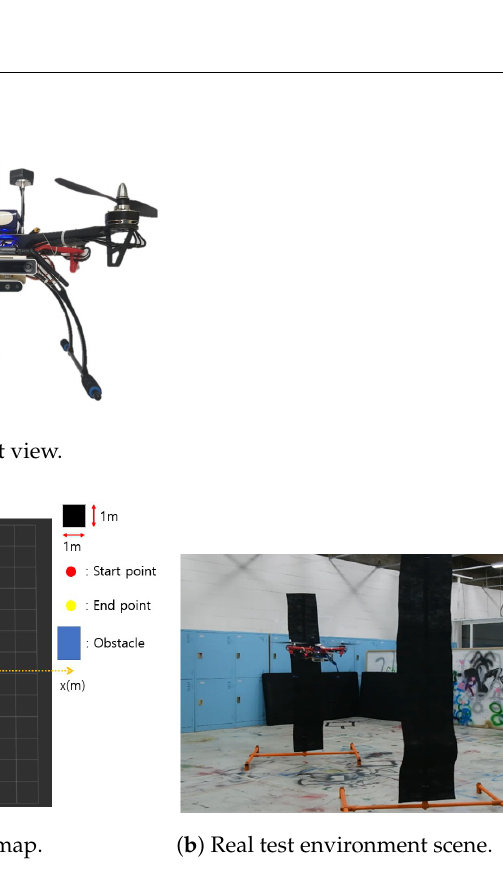
Figure 11. Real test.